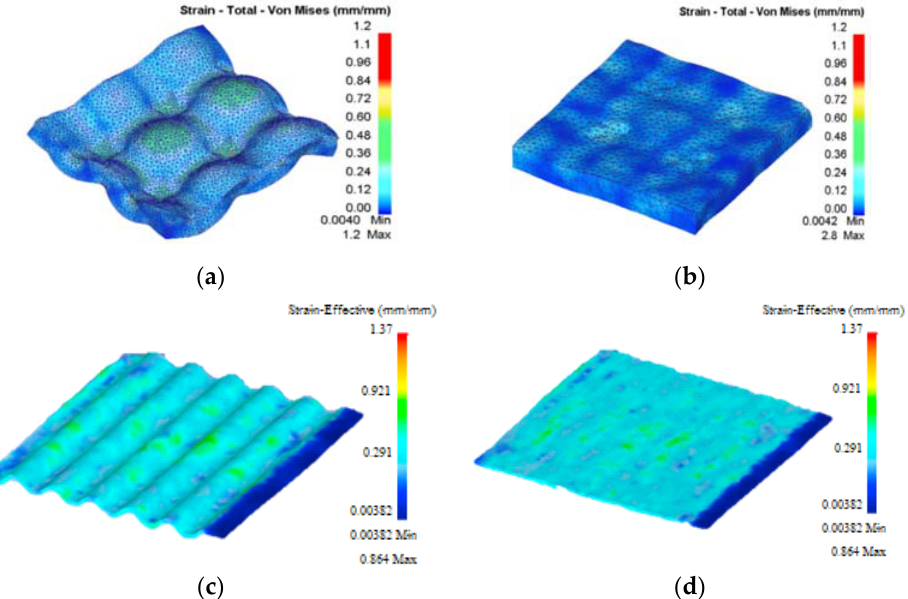
Figure 4. Distribution of effective plastic strain for ( a ) corrugation step and ( b ) straightening step for modified ‐ CSP, and ( c ) corrugation step and ( d ) straightening step for the CGP process from Ref. [16].